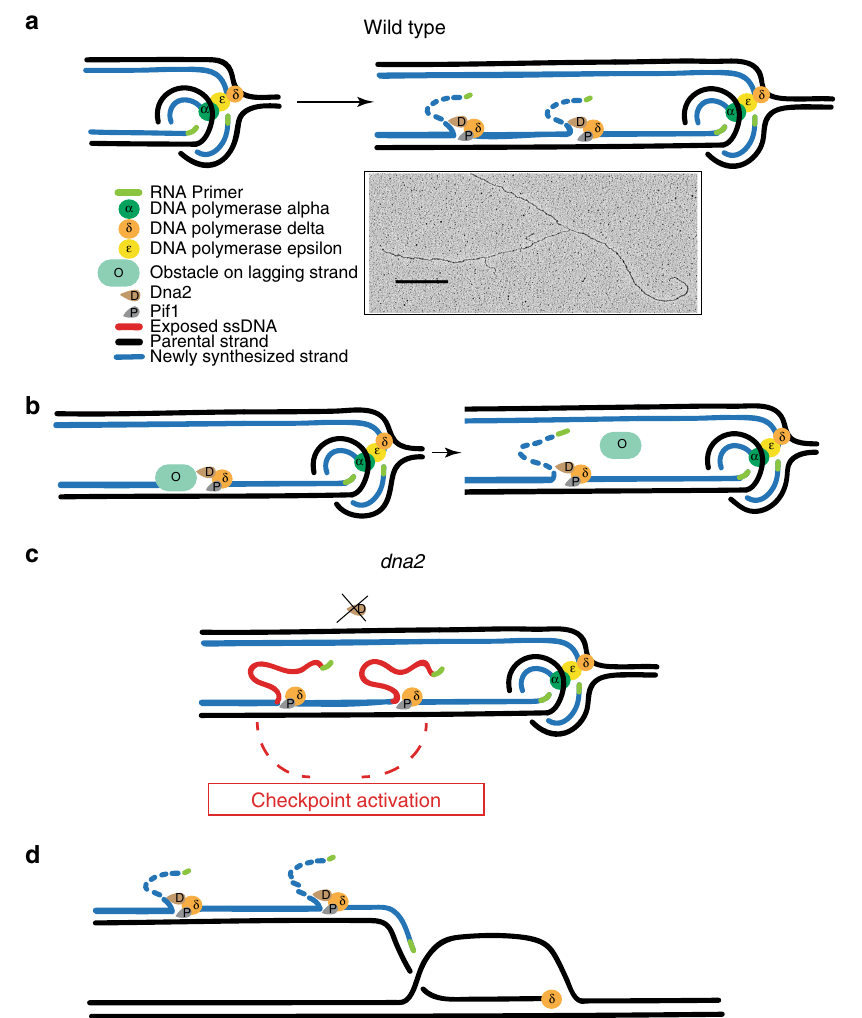
Fig. 5 Model of the Pol δ – Pif1 – Dna2 assisted strand displacement and DNA fl ap cutting during DNA replication. a During unperturbed DNA replication extended and frequent Pol δ – Pif1 strand displacement events create long DNA fl aps, which are immediately cut by Dna2. The Pol δ – Pif1 – Dna2 machine might progress far from the fork branching point. EM picture of a rare fork with two DNA fl aps in the proximity of the fork branching point. A black scale bar as in Fig. 3 is reported. b Re-priming coupled with Pol δ – Pif1 – Dna2 strand displacement may remove lagging strand DNA replication obstacles. c In the absence of Dna2, Pif1-and fork speed-dependent DNA fl aps accumulate on the lagging strand leading to checkpoint hyper-activation and cell death. If Dna2-depleted cells escape the fi rst cell cycle arrest ( rad9 Δ condition) genome instability arises (rDNA fragmentation). d The Pol δ – Pif1 – Dna2 machine acts during conservative BIR-associated lagging strand DNA phenotypes in all the tested conditions and degrade Dna2 with the same kinetic. Dna2 degradation was obtained by treating Tc-dna2-AID cells with 3-indole-acetic-acid